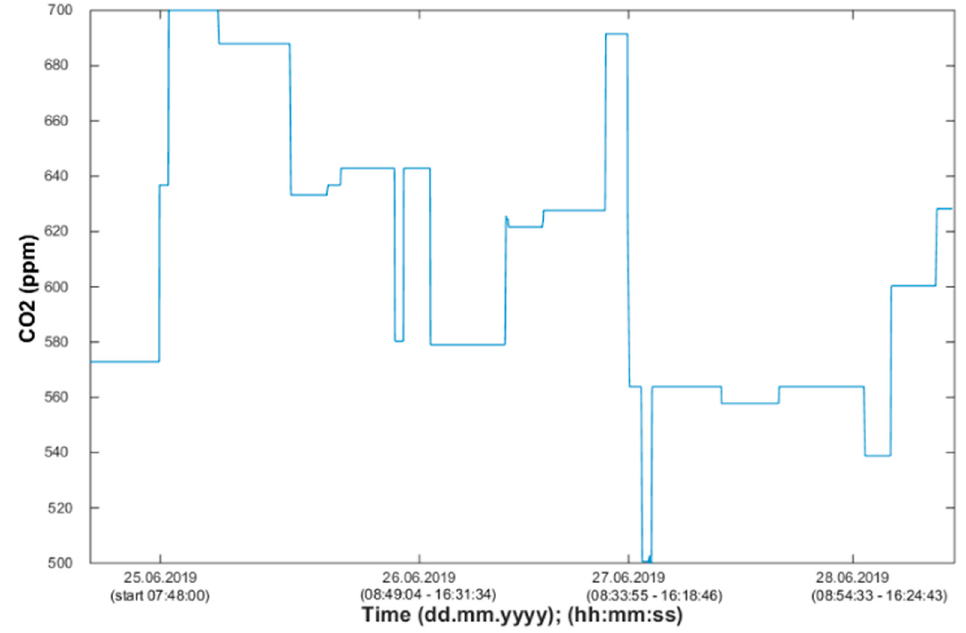
Figure 14. Waveforms of the CO 2 concentration values measured in SH room R104 (BT 12.09).